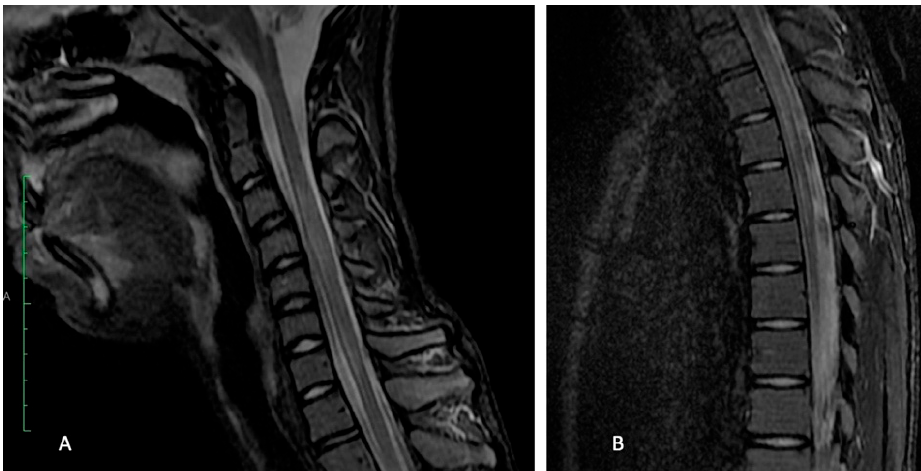
Figure 1. Sagittal STIR MRI at acute onset: intradural hyperintensity seen in the cervical ( A ) and dorsal ( B ) segments, with mild expansion of cord in cervical C3-C5 part.